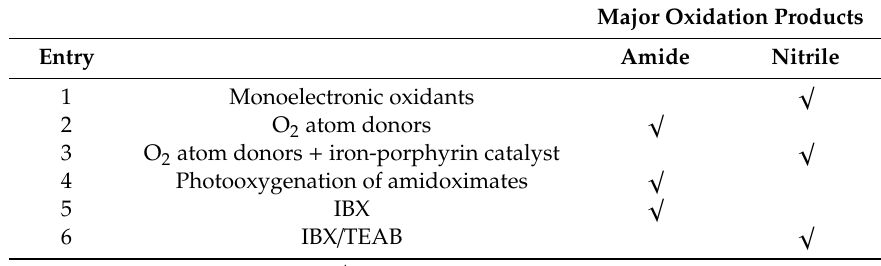
Table 5. Summary of the major oxidation products after amidoxime reaction with di ff erent chemical and biomimetic